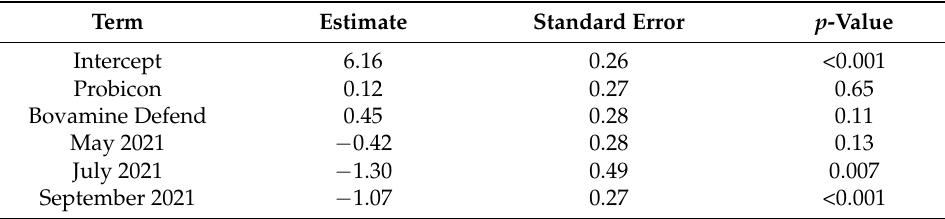
Figure 5. Enterobacteriaceae concentration in fecal samples collected from the pen floors over the course of 4-month sampling period at three different feed yards ( n = 3 pens/feed yard). Error bars represent 95% confidence intervals (CI). Table 5. Results of the GEE analysis for Enterobacteriaceae concentration.